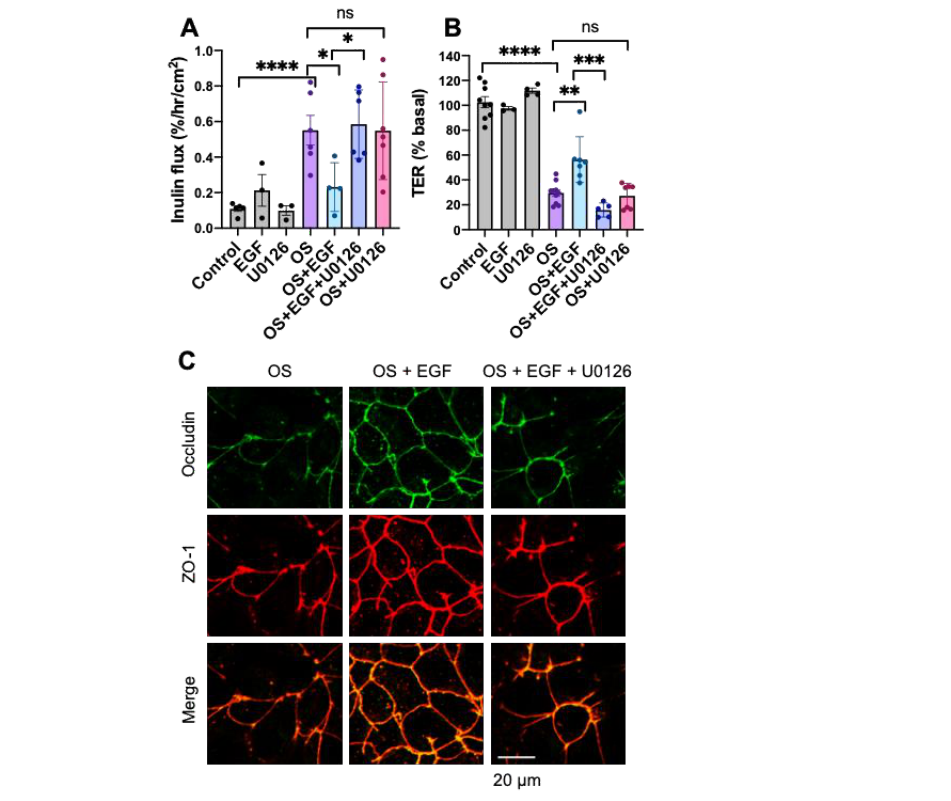
Figure 4. EGF prevents osmotic stress-induced tight junction disruption and barrier dysfunction by a MAP kinase-dependent mechanism. ( A , B ) Caco-2 cell monolayers (14 days post-seeding) were pretreated with or without U0126 (10 µ M) for 30 min before incubation with EGF (30 nM). After 30 min EGF treatment, cell monolayers were exposed to osmotic stress (OS) by incubation in the hyperosmotic medium; the control group received similar treatment without EGF, U0126, or OS. Other controls included EGF-alone or U0126-alone treatments. Inulin flux ( A ) and TER ( B ) were measured at one hour of OS treatment. Values are mean ± SEM ( n = 3-6 from two experiments for inulin flux; n = 3–9 from three experiments for TER); * = p <0.05; ** = p < 0.01; *** = p < 0.005; **** = p < 0.001; “ns” = not significant. ( C ) After 90 min OS treatment, cell monolayers were fixed and co-stained for occludin (green) and ZO-1 (red). Fluorescence images were captured by confocal microscopy. The orange color in merged images indicate co-localization of occludin and ZO-1.